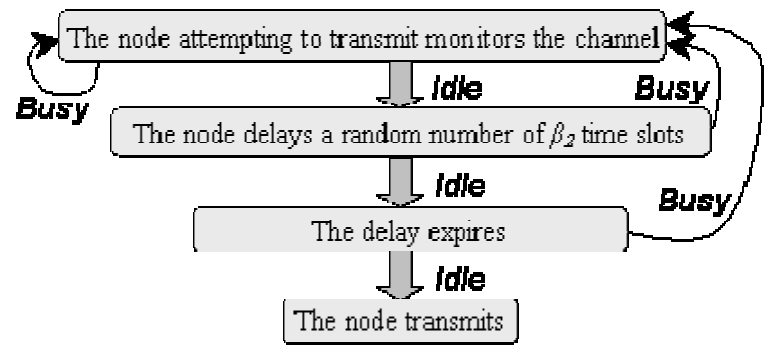
Figure 2. Carrier Sense Multiple Access (CSMA)